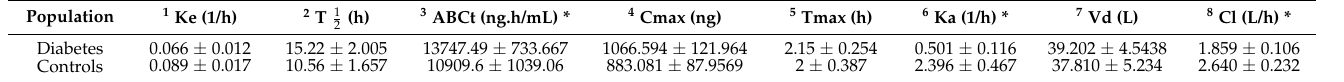
Table 3. Pharmacokinetic parameters of the studied populations.